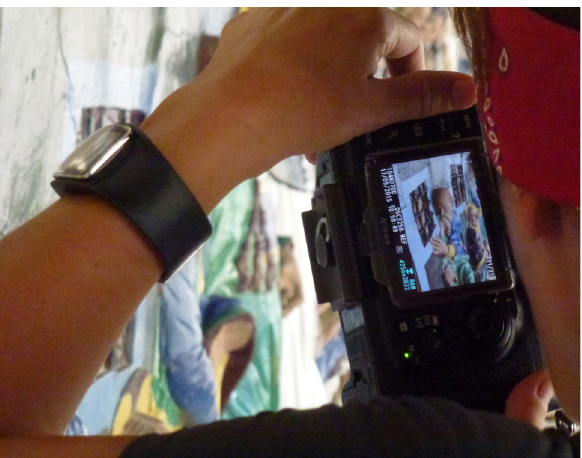
Figure 1. Taking photogrammetric imagery from the scaffolding: for close-up images it was not possible to use even the